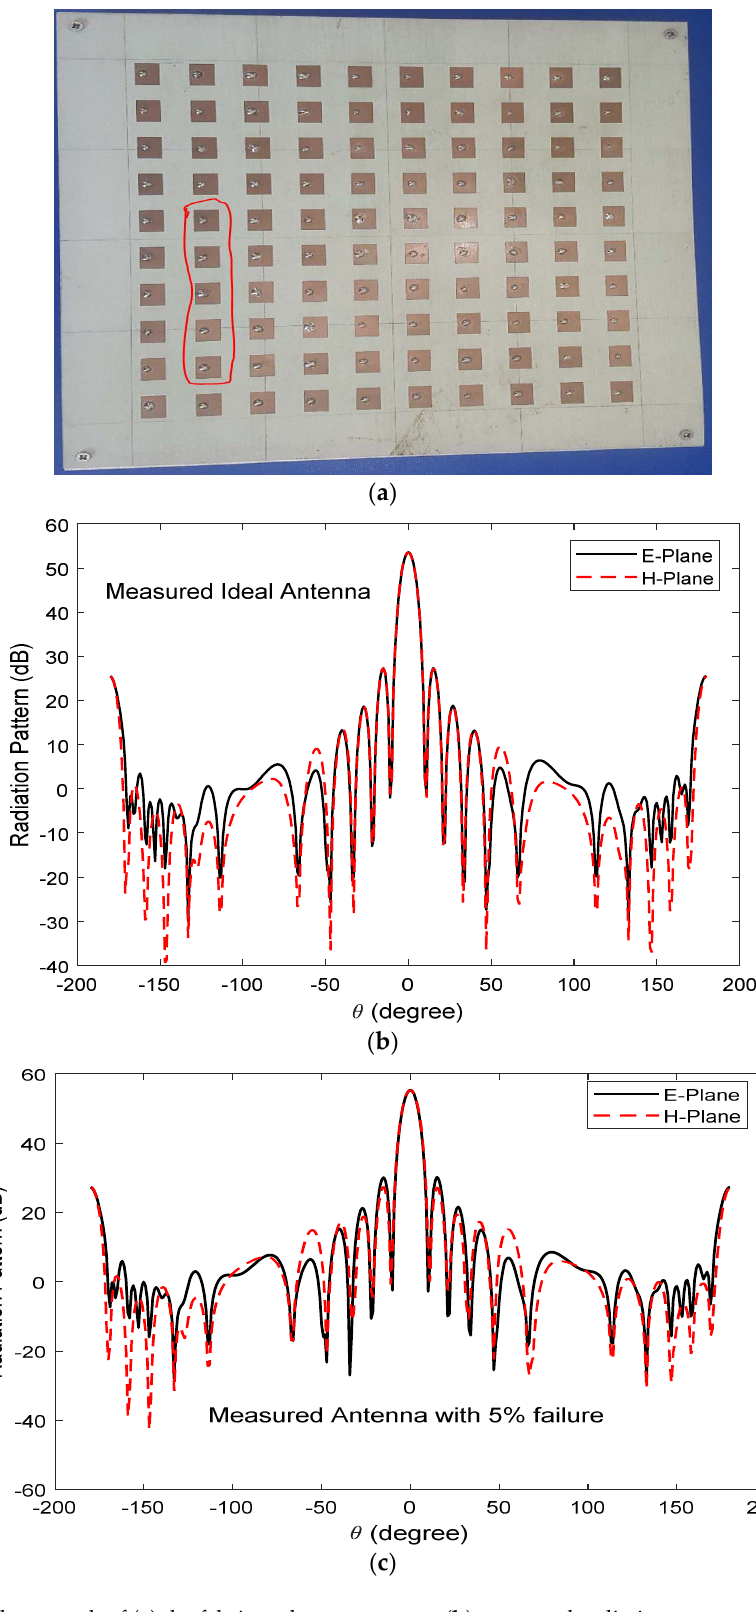
Figure 17. Photograph of ( a ) the fabricated antenna array, ( b ) measured radiation pattern without fault, and ( c ) measured radiation pattern with emulated failures.